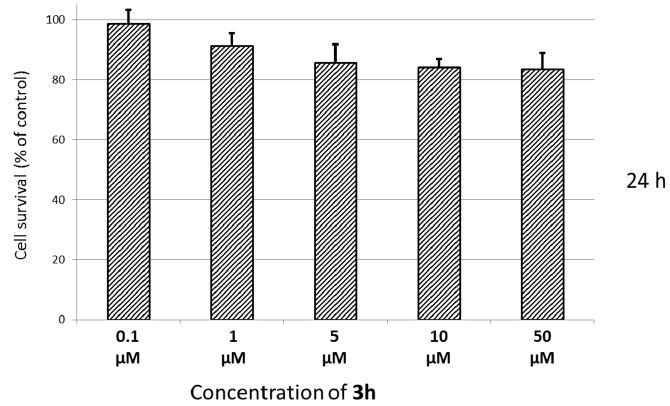
Figure 1. Viability of human neuroblastoma SH-SY5Y cells incubated for 24 h with Compound 3h at different concentrations (range 0.1–50 µM). Untreated cells were used as the control. Results are expressed as the percentage of viable cells observed after treatment with Compound 3h vs. untreated control cells (100%) and shown as the mean ± SD ( n = 3).